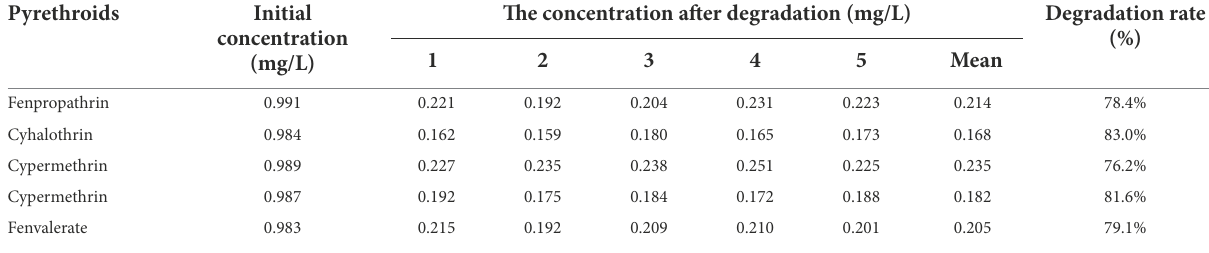
TABLE 3 Degradation rate of five pyrethroids by Est882@SBA-15.